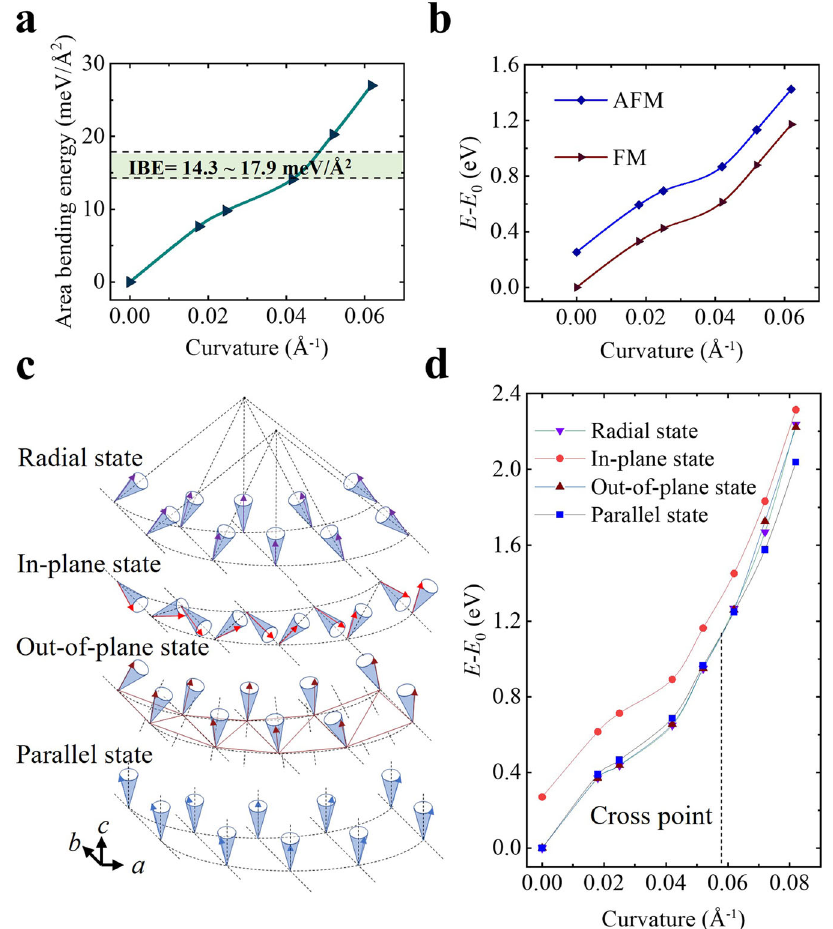
Fig. 2 Energetics and spin con fi gurations of CrI 3 with a series of curvatures. a Bending energy density as a function of the curvature. The light green area is the range of the van der Waals interlayer binding energy (IBE) of bulk CrI 3 . b Energy differences between AFM and FM con fi gurations. The total energy of the FM state at zero curvature, E 0 , is used as the energy reference. c Schematics of four main spin states where the cones are the classical precession trajectories of thermally excited spins (arrows). d Energy of different spin states as a function of curvature relative to the energy of the parallel state at zero curvature E 0